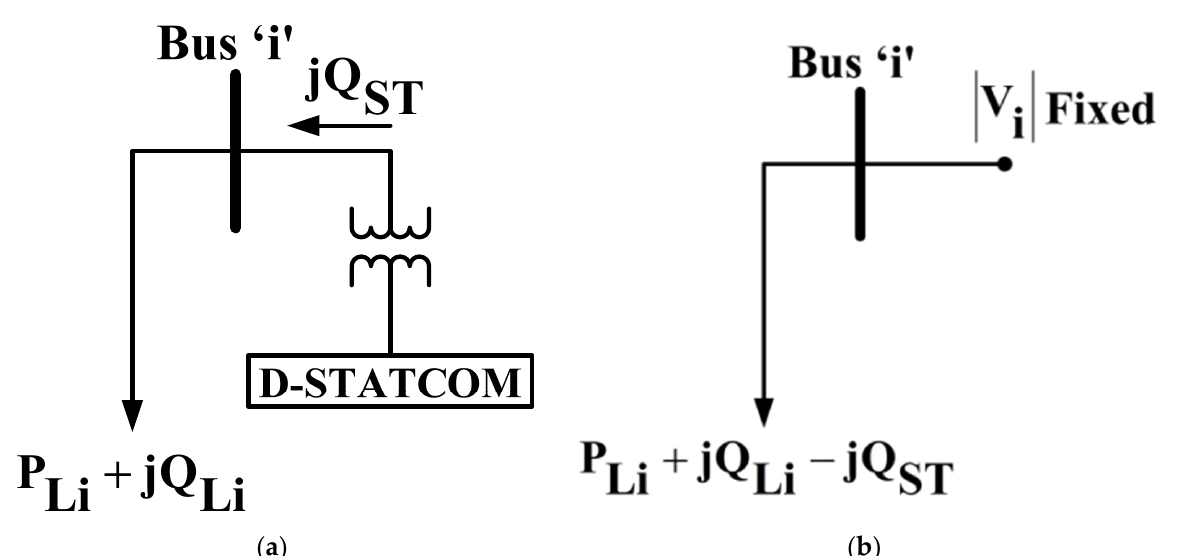
Figure 2. ( a ) D-STATCOM interface at i-th bus. ( b ) Traditional modeling of a D-STATCOM as a PV bus.